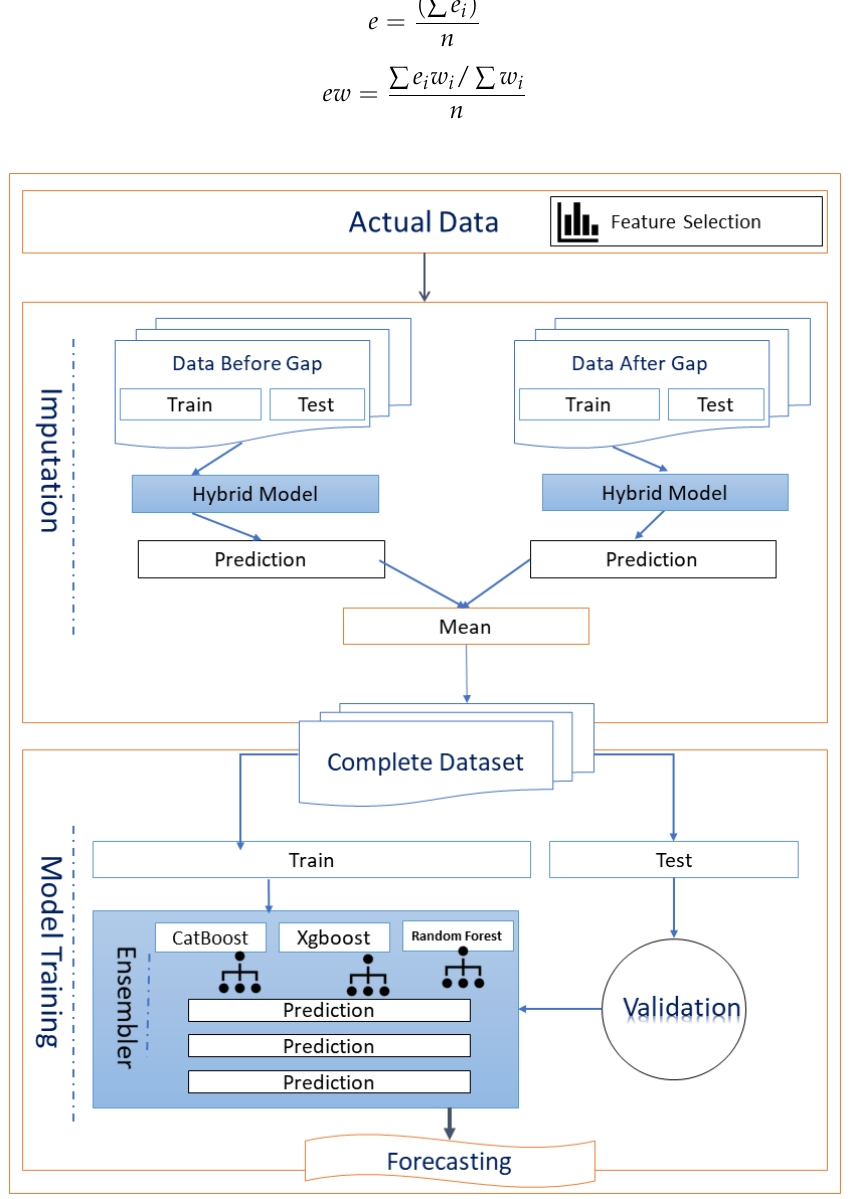
Figure 4. Architecture of proposed imputation and forecasting